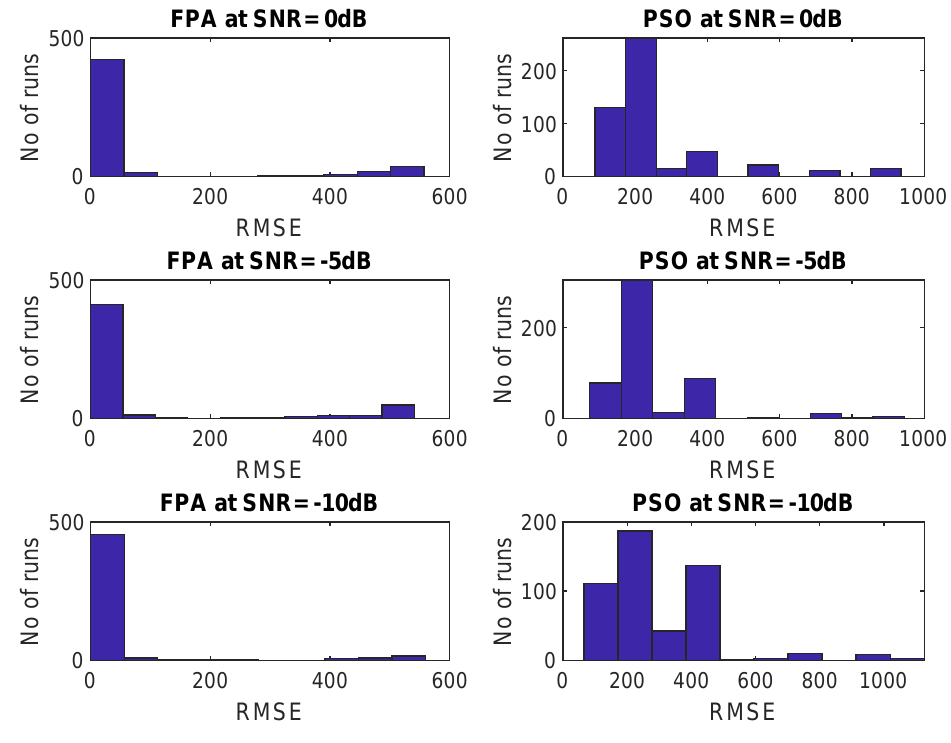
Figure 16. Histogram analysis of RMSE for seven targets.